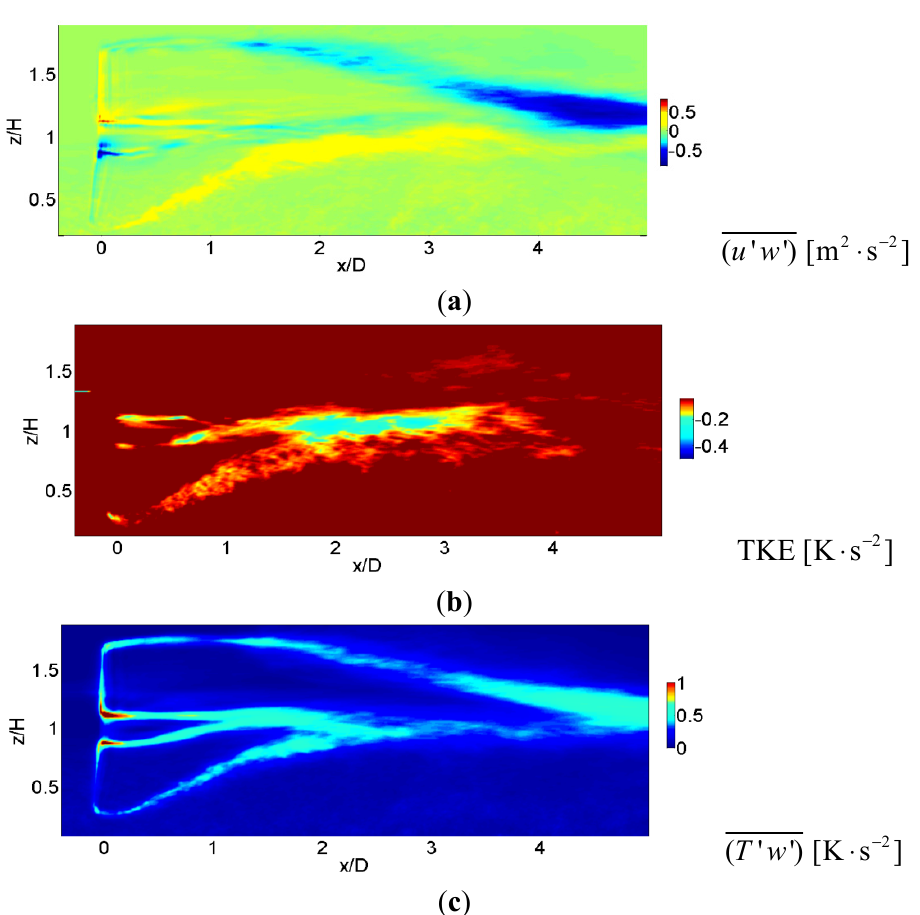
Figure 9. Time-averaged contours of ( a ) Reynolds shear stress; ( b ) TKE; ( c ) in the x-z plane for WT in moderate -stable ABL